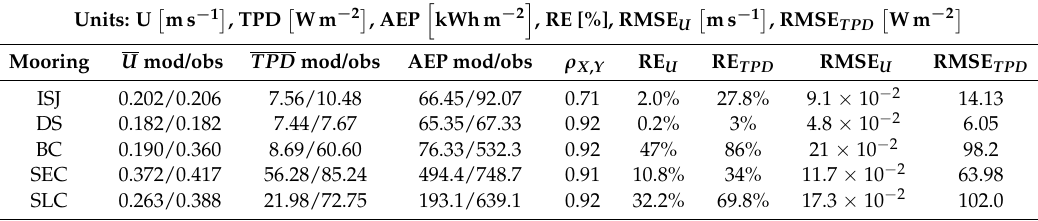
Figure 1. Model domain and bathymetry with markers showing ADCP moorings. Table 1. Verification table for mean